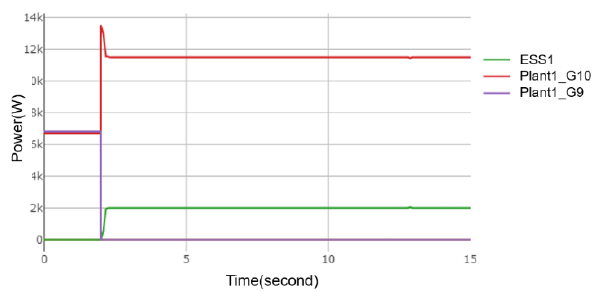
Figure A1. N-1 contingency frequency at 9th hour of first ED.